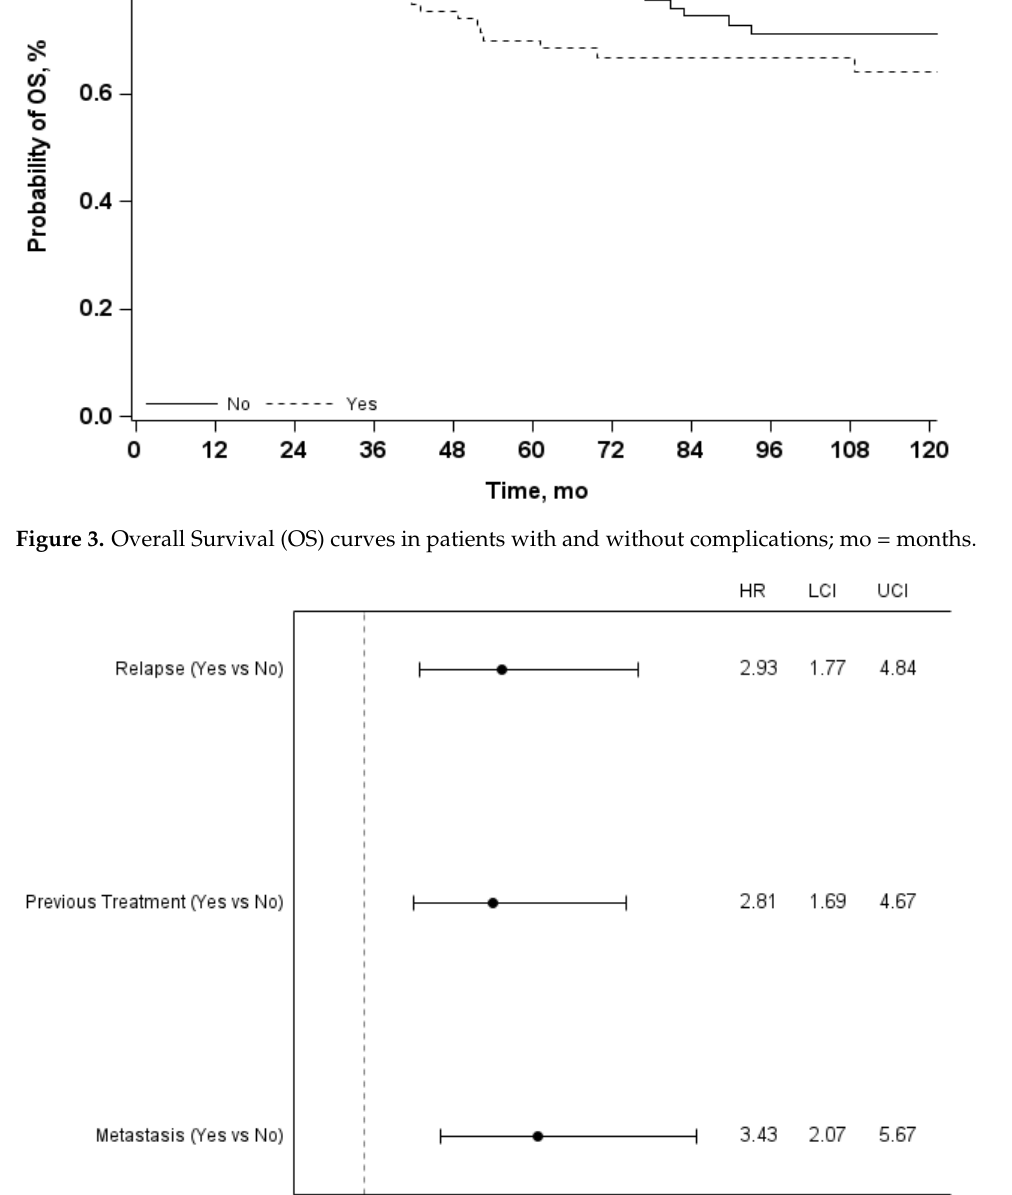
Figure 4. Forest plot for Overall Survival in association with prognostic factors significant in the multivariable model.